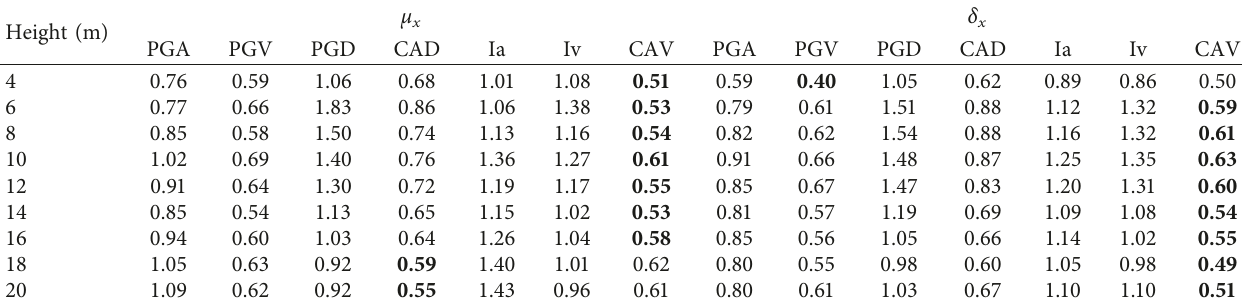
Figure 15: IMs proficiency comparison for (a) the bearing deformation along the longitudinal direction and (b) the bearing deformation along the transverse direction. Table 7: Demand models and proficiency comparison of IMs subjected to far-field ground